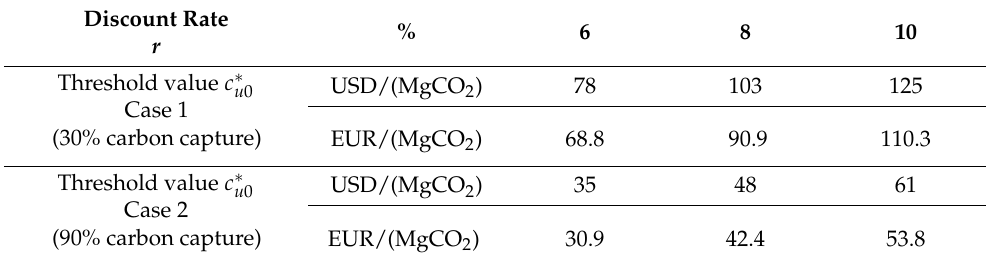
Table 6. The threshold values of the price of a CO 2 allowance.